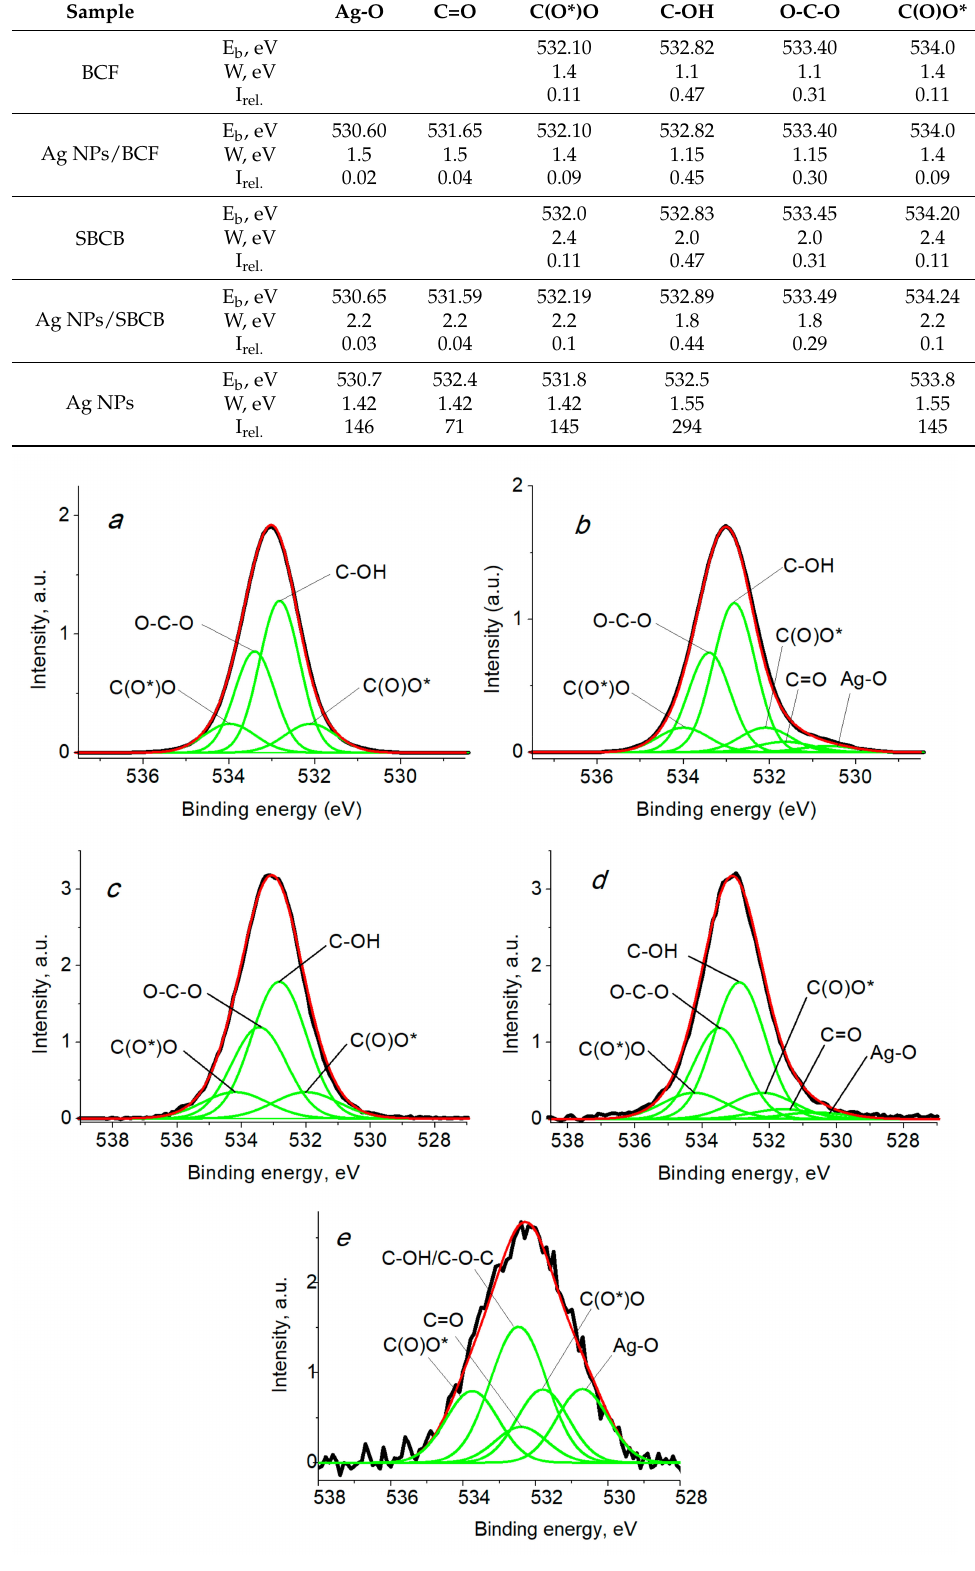
Figure 8. The O 1s photoelectron spectra of samples BCF ( a ), Ag NPs/BCF( b ), SBCB ( c ), Ag NPs/SBCB ( d ) and Ag NPs ( e